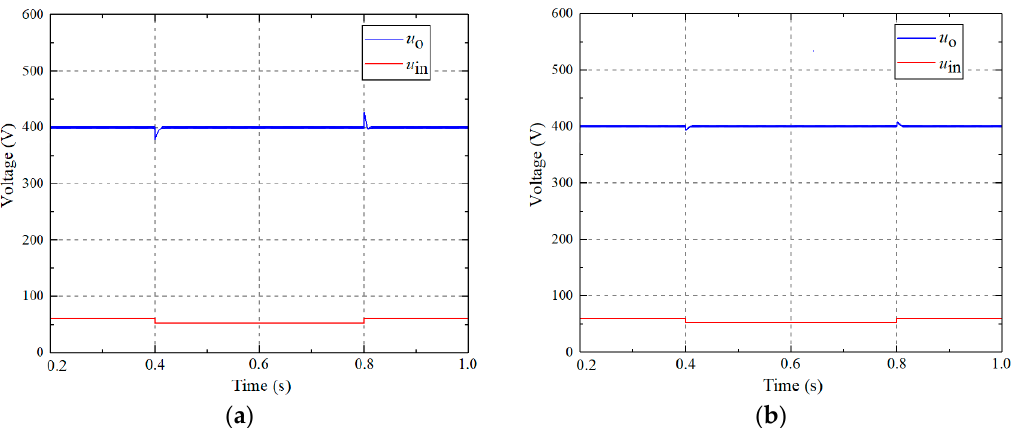
Figure 6. The output voltage variations under input voltage disturbance. ( a ) With only feedback controller; ( b ) with feedback controller and feedforward compensation.